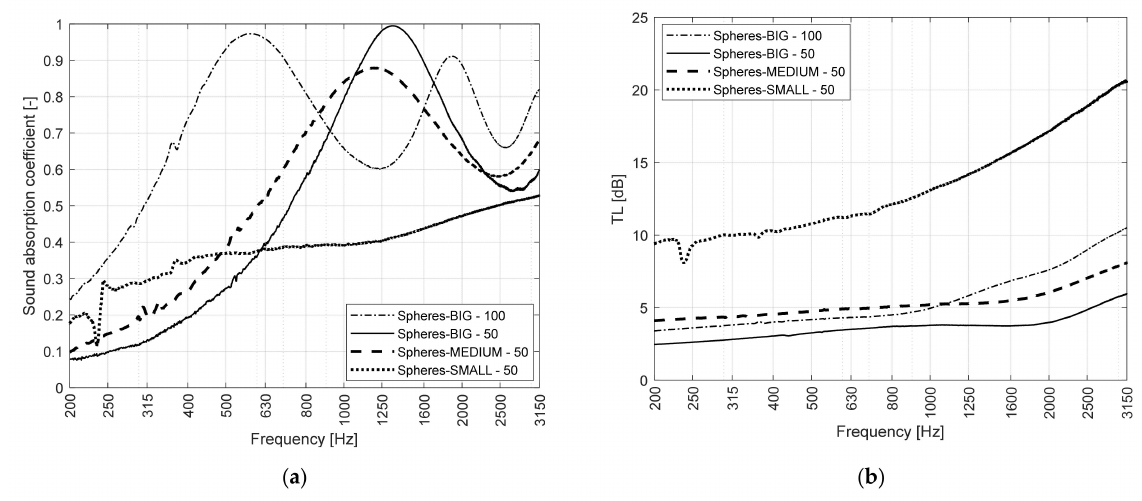
Figure 9. Acoustic properties of slag spheres samples BIG, MEDIUM and SMALL: ( a ) sound absorption coefficient; and ( b ) transmission